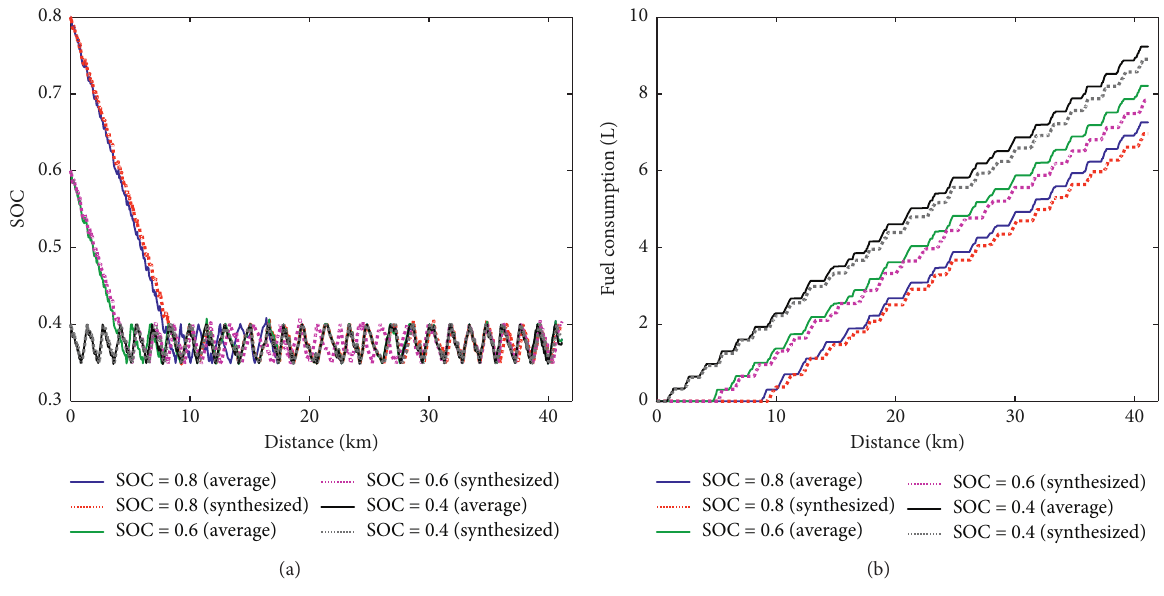
Figure 28: Comparison of SOC and FC between average passengers and synthesized. (a) SOC changing and (b) fuel consumption. Table 4: Fuel consumption comparison of the synthesized cycle and measured